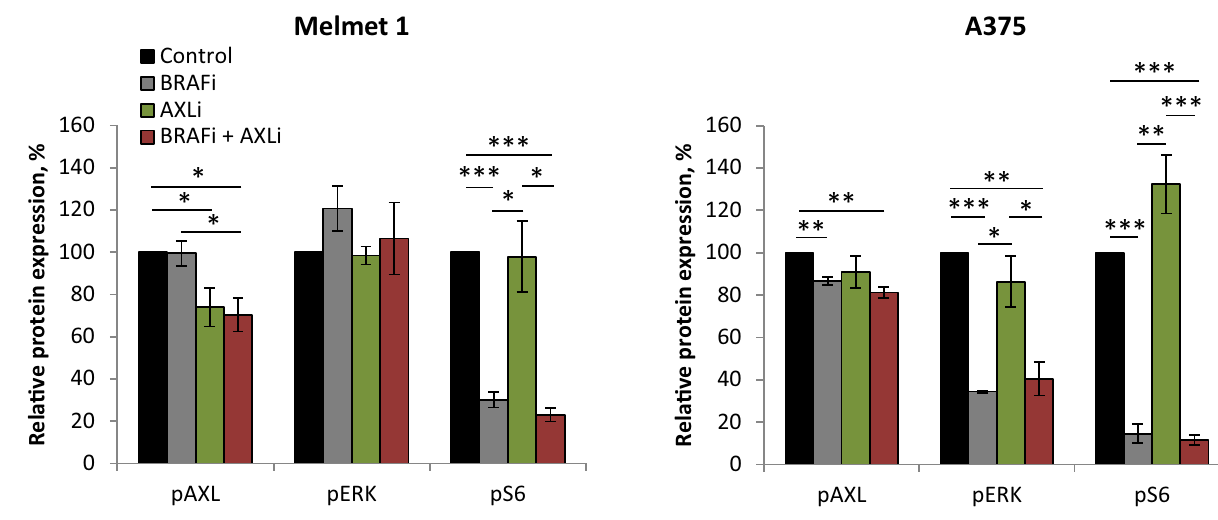
Figure 4. Melanoma cells show response to BRAFi and AXLi. Expression levels of proteins measured by FLOW (recording ≥ 2.5 × 10 4 cells) in the differently treated Melmet 1 and A375 cells (2 µM BRAFi, 2 µM AXLi or a combination of both, DMSO for control) for 48 h and presented as relative to respective non-treated controls set to 100%. Average of signal median ± SEM, n = 3. * p ≤ 0.05; ** p ≤ 0.01; and *** p ≤